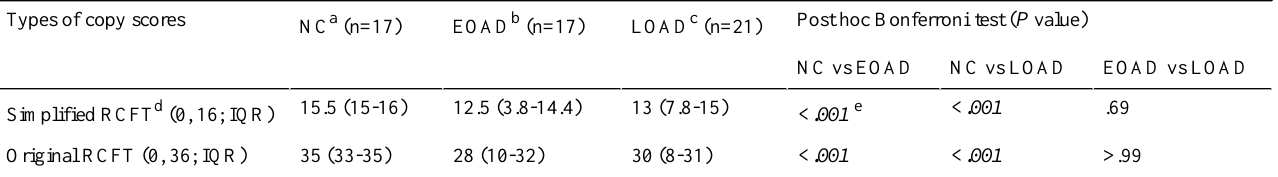
Table 2. Raw copy scores for the original and simplified Rey-Osterrieth Complex Figure